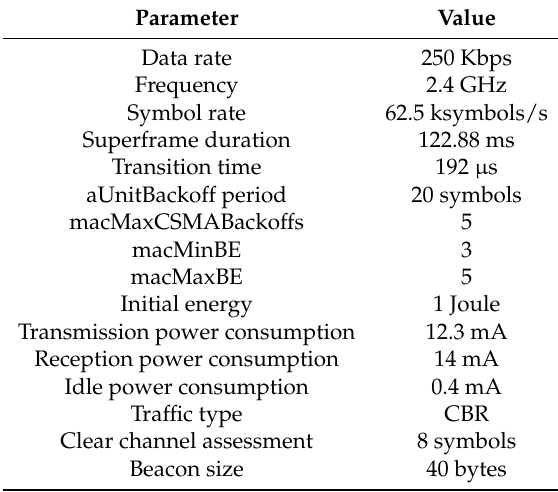
Table 2. Simulation